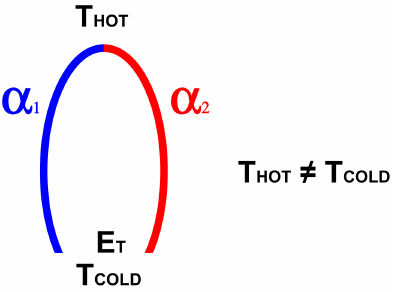
Figure 2. Simple thermocouple—red and blue mark different